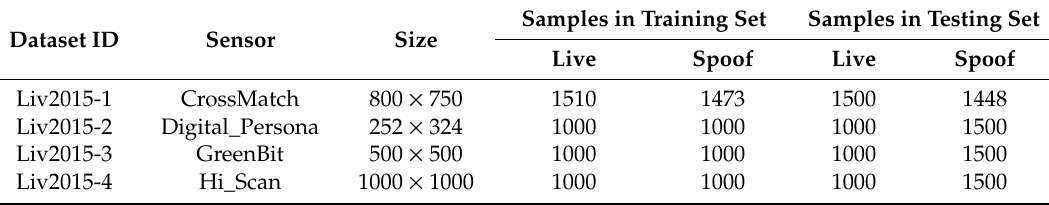
Table 4. The image distribution of the LivDet 2015